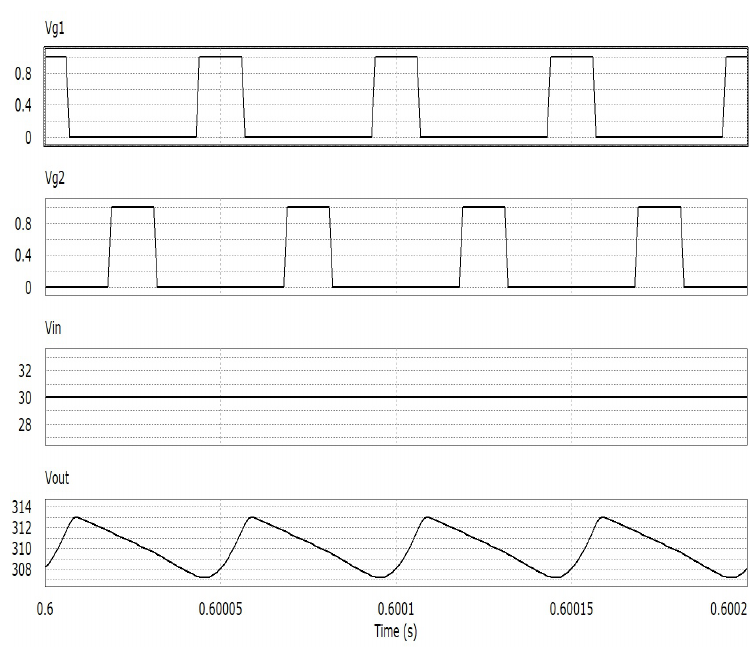
Figure 10. Simulation of gate pulses: input voltage and output voltage.